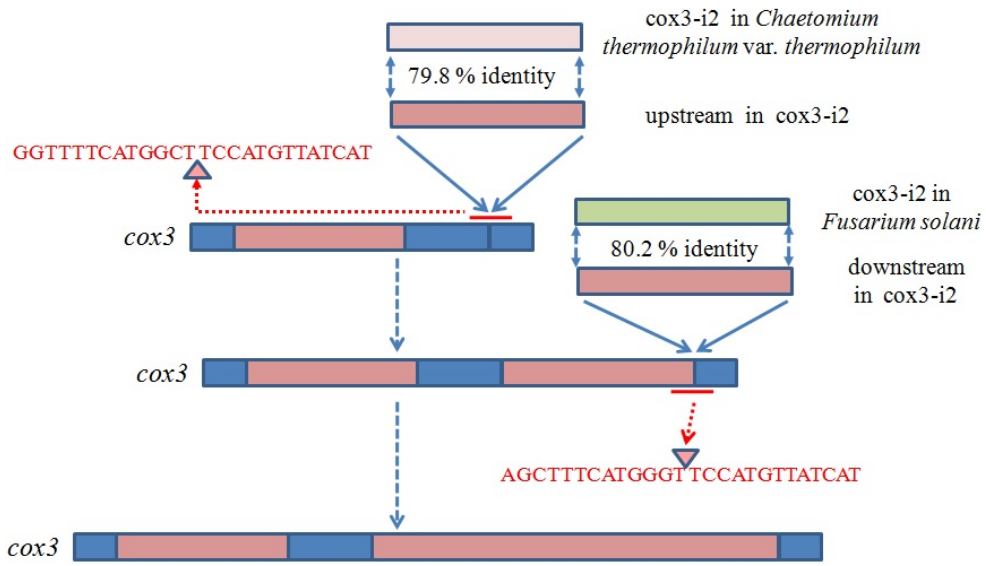
Figure 5. Probable forming process of cox3 ‐ i2. Blue regions represent exons, brown regions represent introns of H. aurantius, pink region represents cox3 ‐ i2 in Chaetomium thermophilum var. thermophilum , green region represents cox3 ‐ i2 in Fusarium solani , and red lines represent insertion sites in. Deduced insertion sites are shown in red font.